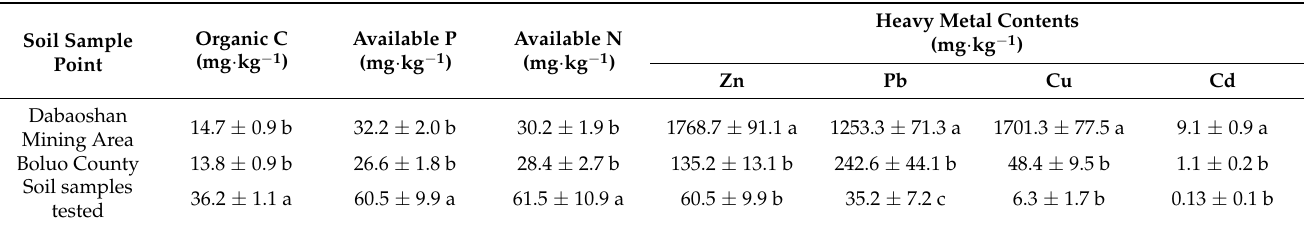
Table 1. The basic chemical properties of the soil at the sampling points of two ecotypes of M. floridulus and the soil for the pot